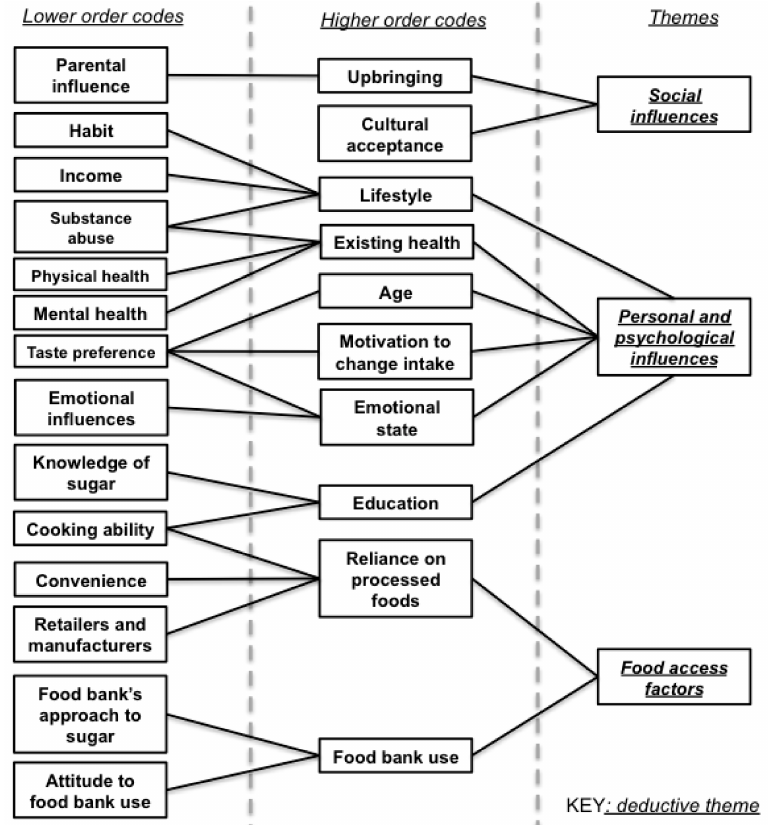
Figure 2. Hierarchical model of themes affecting sugar consumption behaviours.